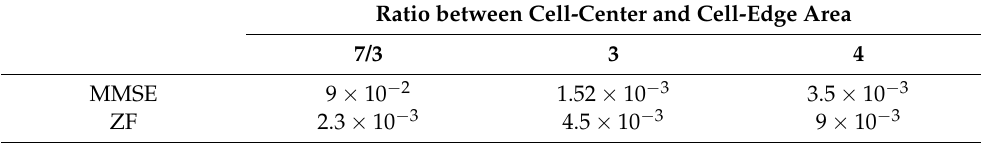
Figure 13. Capacity comparison between different values of center-edge area ratio for MU-network MIMO with ZF joint preprocessing.